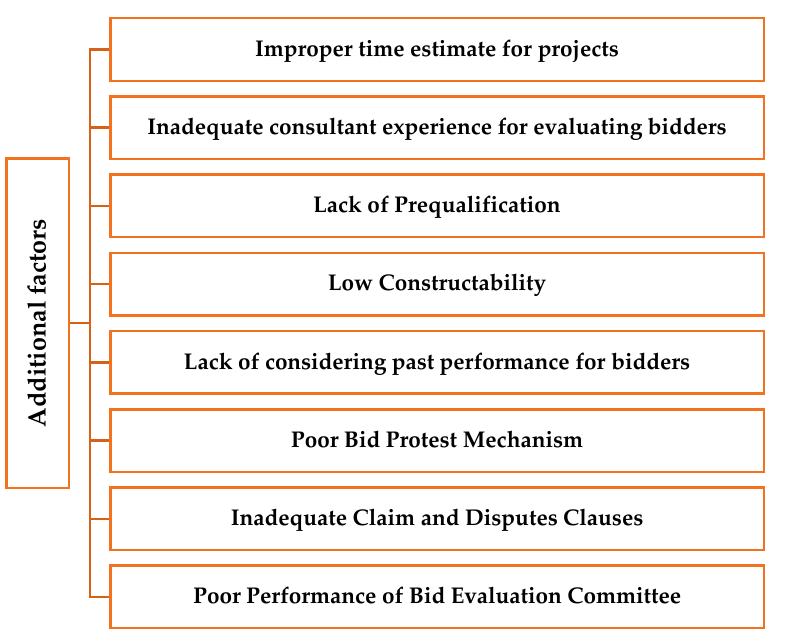
Figure 4. Additional challenging factors.